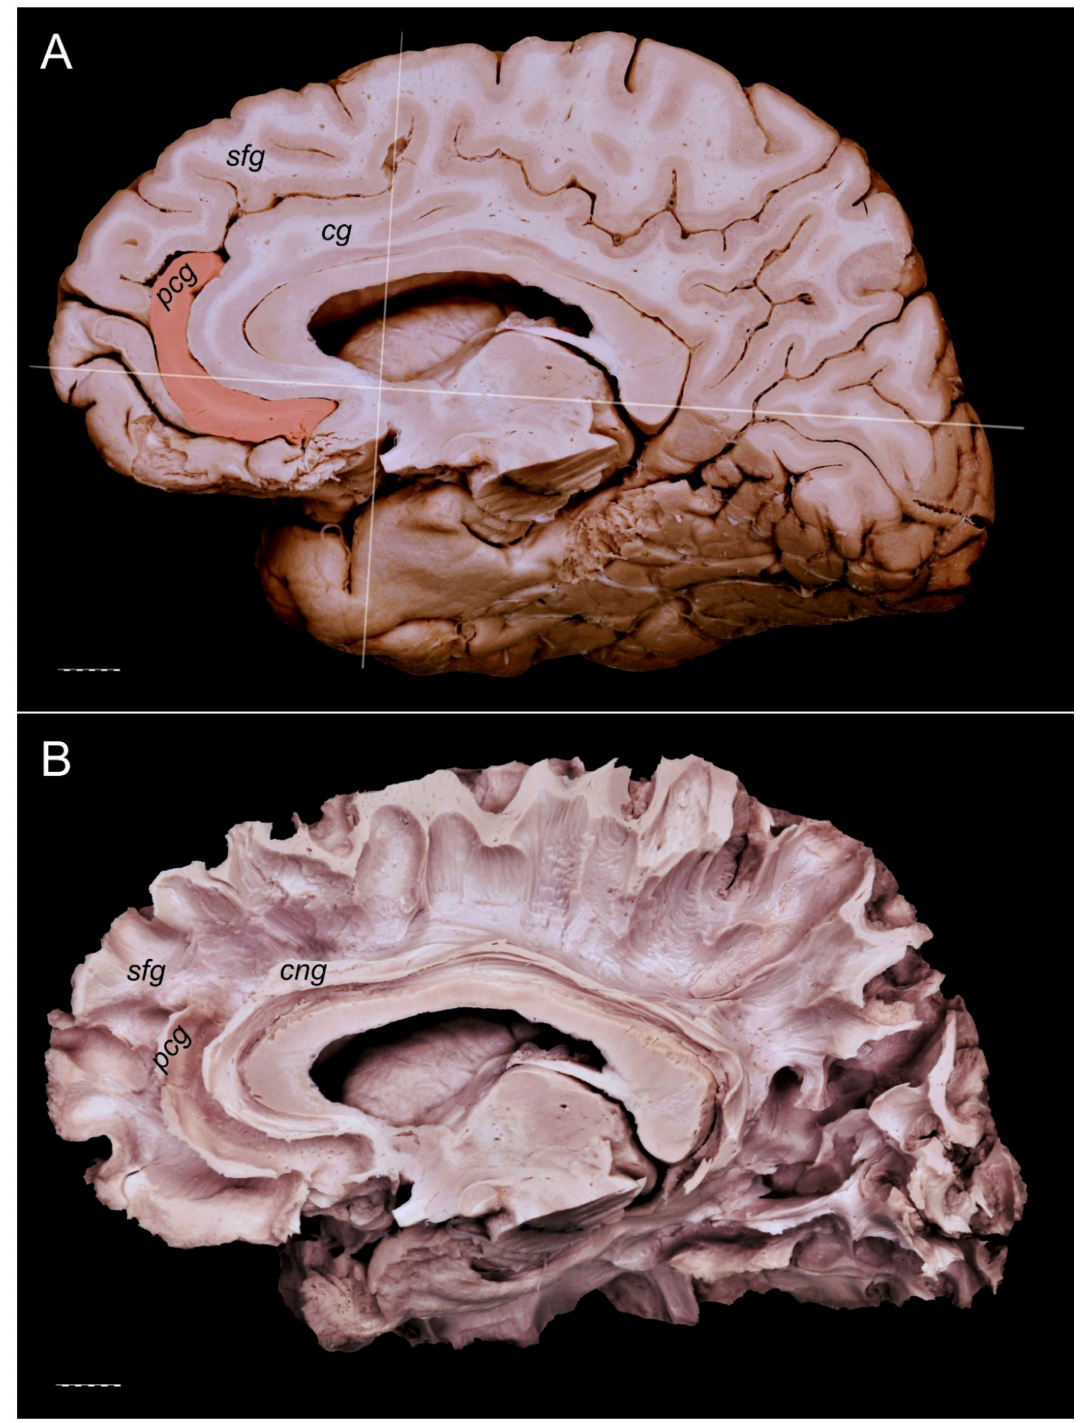
Figure 6. An ambiguous case. Medial view of the right cerebral hemisphere. This type can be classified as absent (PCS < 20 mm). From an anatomical point of view, based on a dissection performed using Klingler’s technique, it can also be classified as an “underdeveloped type.” ( A ) The vestigial PCG is colored orange. The VAC and AC-PC lines are marked. ( B ) The same specimen dissected using Klingler’s technique. The cingulum and white matter fibers of the superior frontal gyrus are visualized. Some white matter fibers of the PCG are exposed. cg—cingulate gyrus; cng—cingulum; pcg—paracingulate gyrus; sfg—superior frontal gyrus. The scale bar corresponds to 10